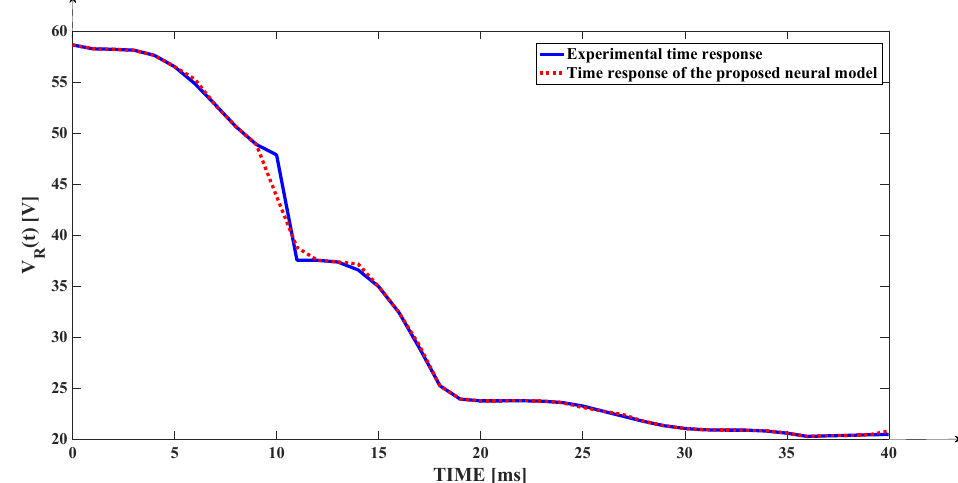
Figure 25. The comparative graph between the V R (t) experimental time response and the response generated by the proposed neural model.